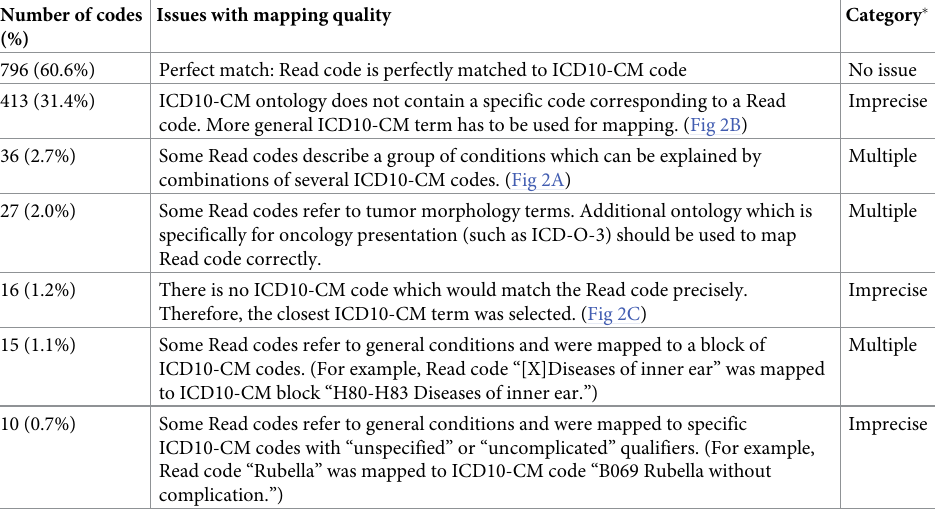
Table 1. Overall quality of mapping Read codes to ICD10-CM codes for a subset of 1,313 randomly selected Read codes from GP clinical data. Number of codes